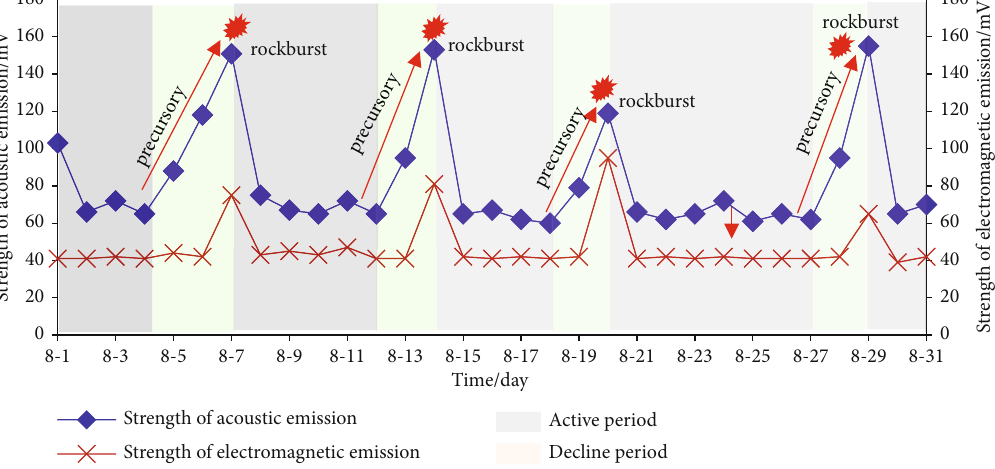
Figure 5: Time-series curve of AE and EME from Aug 1 to 31.